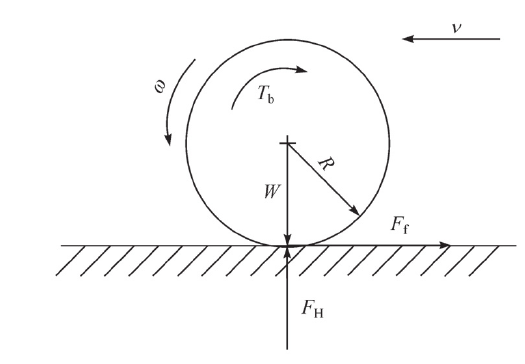
Figure 2. The diagram of wheel motion force.